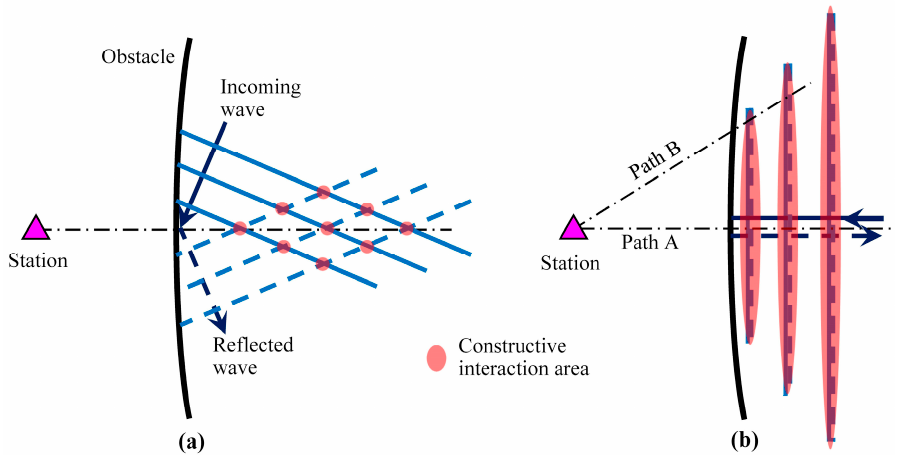
Figure 7. A sketch describing how constructive interactions of ocean waves and their reflections from a barrier (the continental slope or the shoreline) can result in different energies when the angle of incidence is ( a ) large and ( b ) 0°. Note a given station receives the strongest signals along the shortest path A.